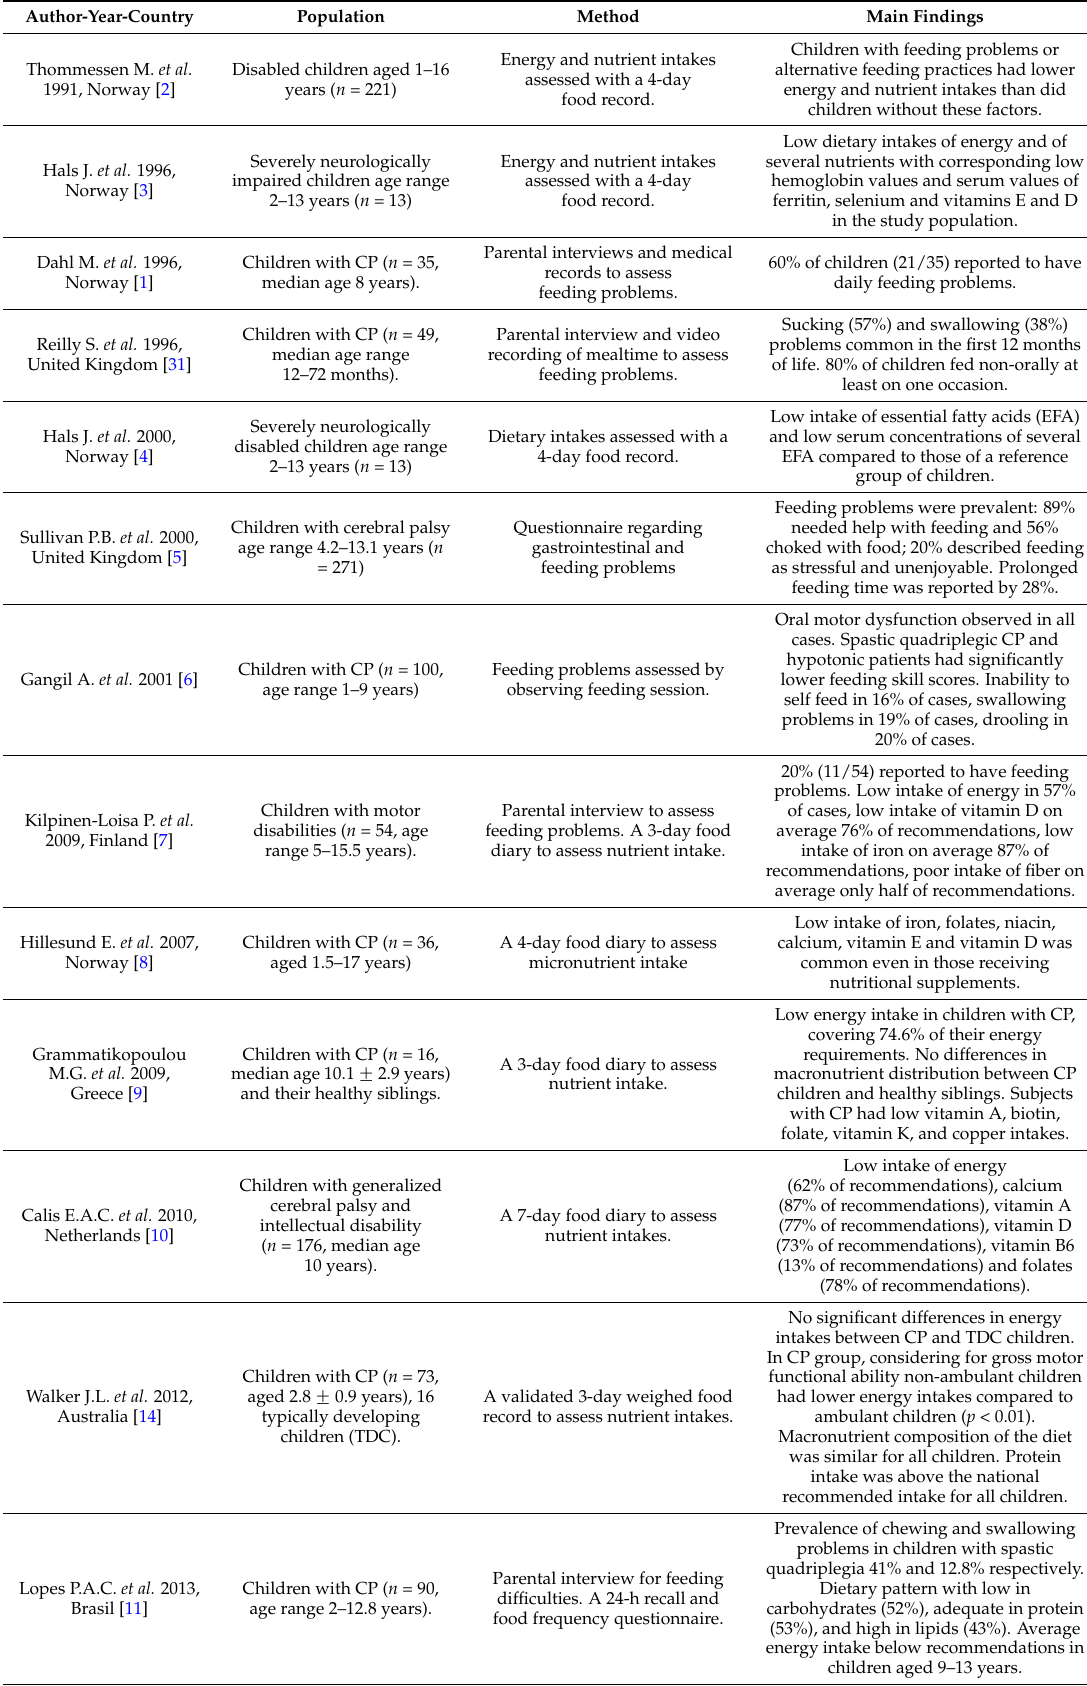
Table 1. Main studies on dietary intakes in neurologically impaired